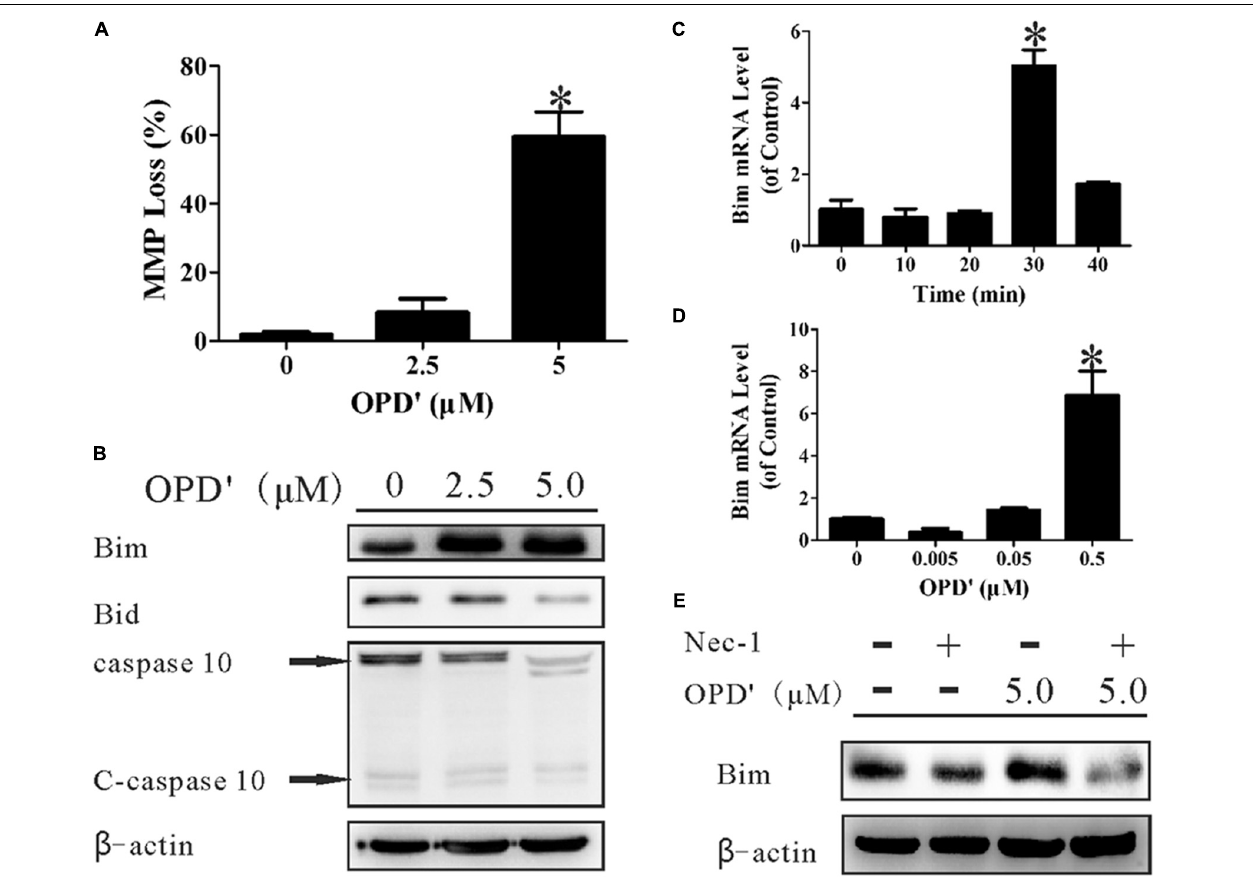
FIGURE 4 | OPD (cid:48) increased the expression of Bim and induced mitochondrial membrane depolarization (loss of MMP). (A) The MMP loss (%) after treatment with 0, 2.5, or 5.0 µ M OPD (cid:48) for 6 h. ∗ p < 0.05 vs. the 0 µ M group. (B) The protein expression levels of Bim, Bid, caspase 10, and C-caspase 10 were examined by Western blotting after treatment of PC3 cells with 0. 2.5, or 5.0 µ M OPD (cid:48) for 6 h. (C) The mRNA expression of Bim was examined by RT-PCR at different time points after treatment with 0.5 µ M OPD (cid:48) . ∗ p < 0.05 vs. the 0 min group. (D) After treatment with various concentrations of OPD (cid:48) (0.005, 0.05, 0.5 µ M) for 30 min, the mRNA expression level of Bim was examined by RT-PCR. The data shown in parts (A,C,D) represent the means ± SD of three independent experiments. ∗ p < 0.05 vs. the 0 µ M group. (E) After pre-treatment with 10 µ M Nec-1 for 2 h, PC3 cells were treated with 5 µ M OPD (cid:48) or the vehicle control for 6 h, then the Bim protein levels were checked by Western blotting. The data shown in parts (B,E) represent the means ± SD of three independent experiments. These panels represent one of the